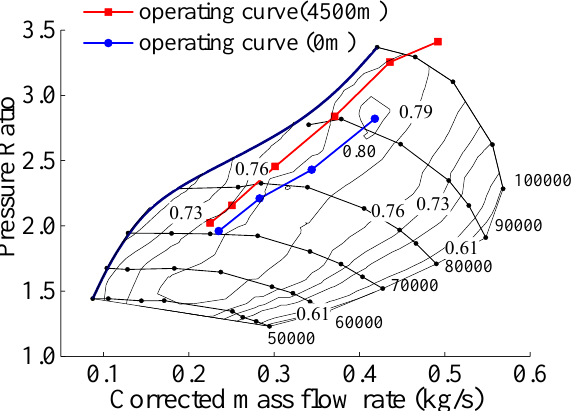
Figure 2. Compressor performance matching with engine operating curves.